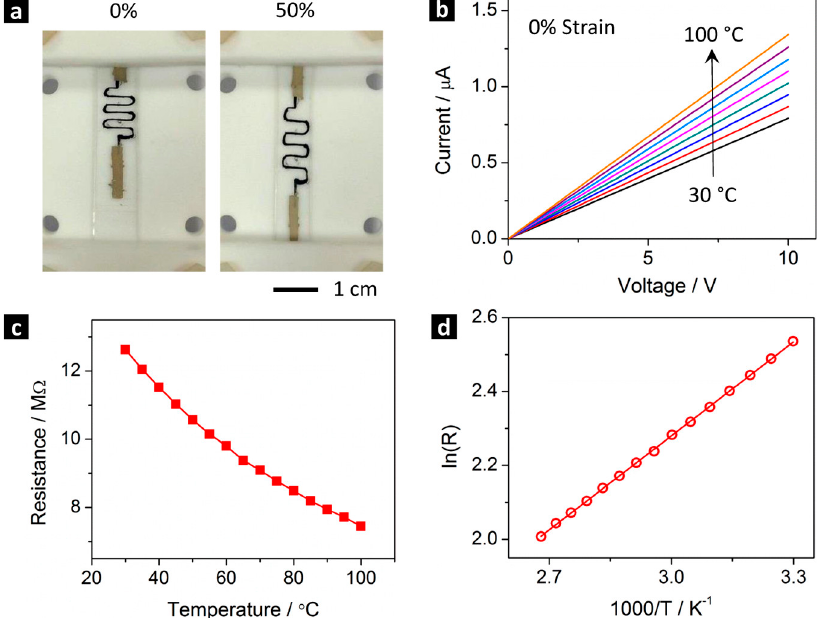
Figure 11. ( a ) Images of the stretchable graphene thermistor at 0 (left) and 50% (right) strain are shown. ( b ) I − V curves of the thermistor at zero strain in the temperature range of 30 − 100 °C (temperature step chosen as 10 °C for clarity). ( c ) A non-linear relationship between resistance fluctuation and temperature is shown. ( d ) A linear relationship between ln(R) and 1000/T is demonstrated [131]. Reprinted with permission. Copyright (2015) American Chemical Society.